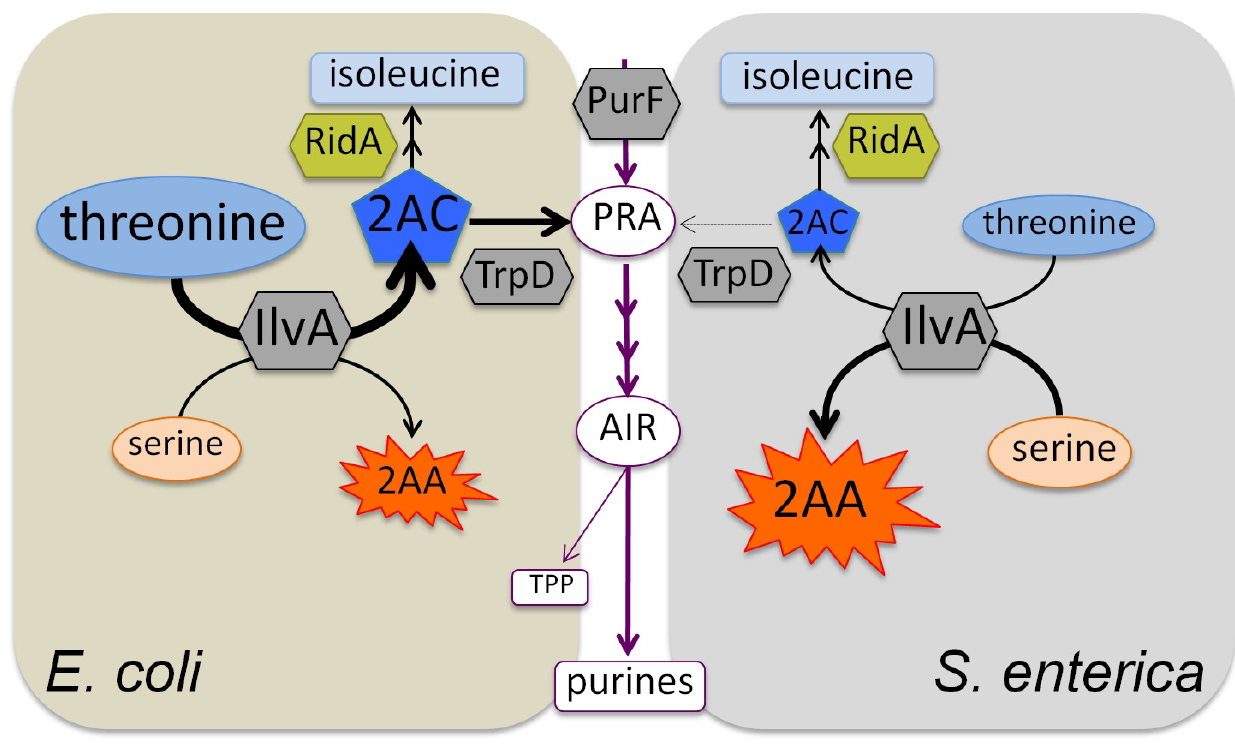
FIGURE 1: S. enterica and E. coli have distinct metabolic network structures surrounding thiamine pyrophosphate (TPP) biosynthesis. The metabolic network structures leading to IlvA/TrpD-dependent TPP synthesis in S. enterica and E. coli are shown. Notably, although E. coli and S. enterica have the same enzymes, TPP biosynthesis from threonine is only detectable in E. coli . A working model suggests that relative levels of threonine and serine, the substrates for IlvA, influence the structure and function of the metabolic network. The purine/TPP pathway is shown in maroon with the first enzyme, PurF, and relevant branch metabolites, PRA and AIR, indicated. The thickness of the arrows is meant to repre- sent carbon flux. The two intermediates in the IlvA reaction mechanism, 2-AC and 2-AA are shown. The diversion of 2-AC to PRA formation is allowed by the concentration of threonine available to IlvA in E. coli . In our model, we hypothesize 2-AA from serine is more prevalent than 2-AC in S. enterica , due to the lower level of threonine available for